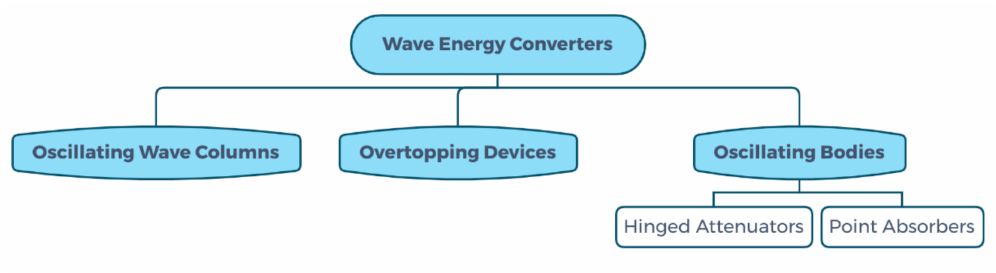
Figure 1. Wave energy converters (WECs) categorized by mechanical